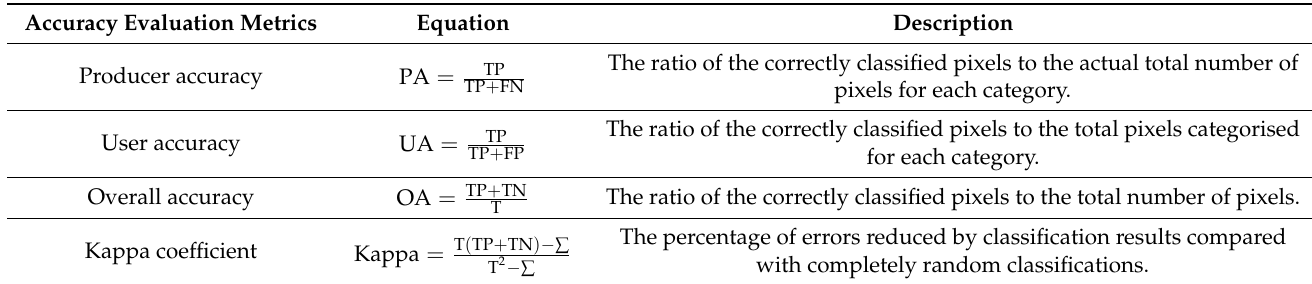
Table 4. Indicators in the accuracy